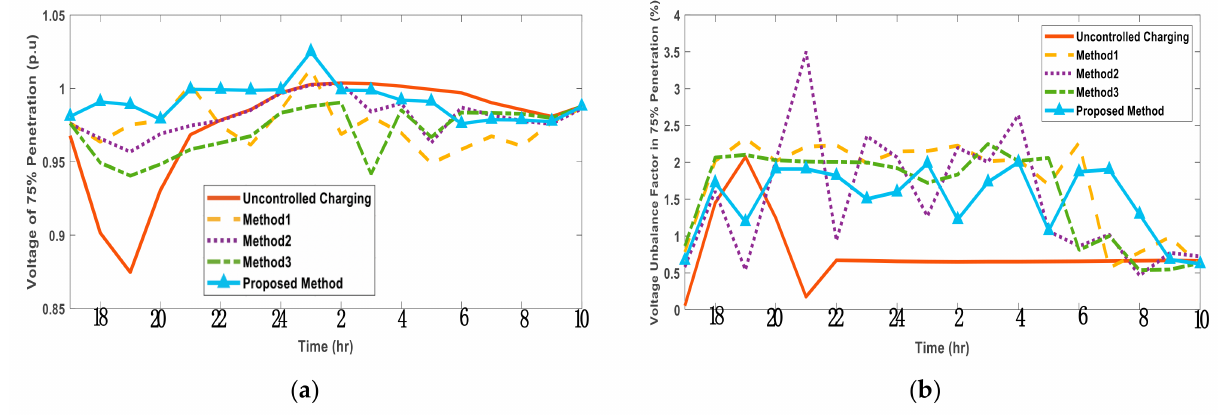
Figure 11. Bus 846 ( a ) voltage and ( b ) VUF under 75% EV